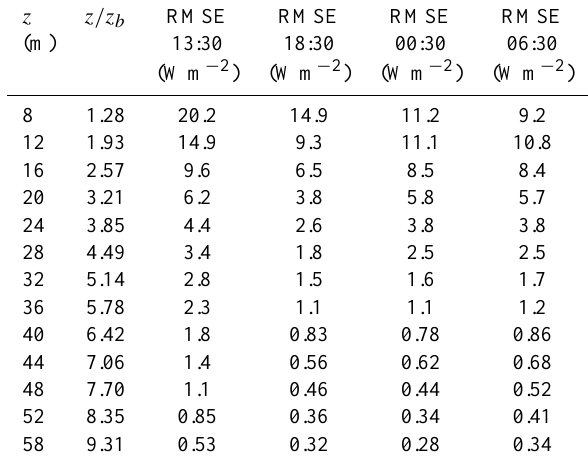
Table 4. RMSE of selected horizontal positions for increase in ra- diometer altitude. Road positions are not